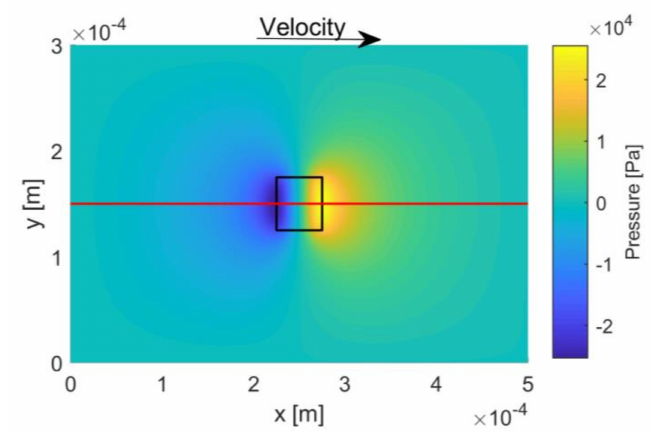
Figure 2. Pressure contour of a square dimple with side 50 µ m and depth 10 µ m. Gap 10 µ m, sliding velocity 5 m /